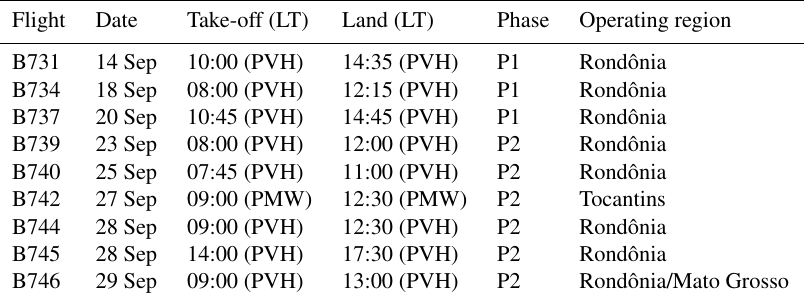
Table 1. Flight summary of the operations included in this study. All flights were conducted during 2012. Local time (LT) is UTC − 4. Take-off and land times include airport used: PVH – Porto Velho; PMW – Palmas. The phases correspond to the synoptic meteorological conditions during the study, where relatively dry conditions were prevalent in Phase 1 (P1), before the period when the monsoonal transition was being established in Phase 2 (P2).